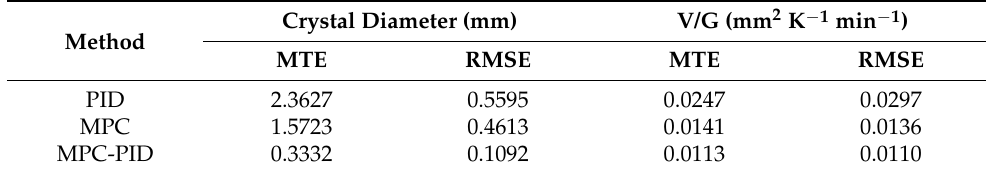
Table 2. MTE and RMSE of control output error under Gaussian noise.